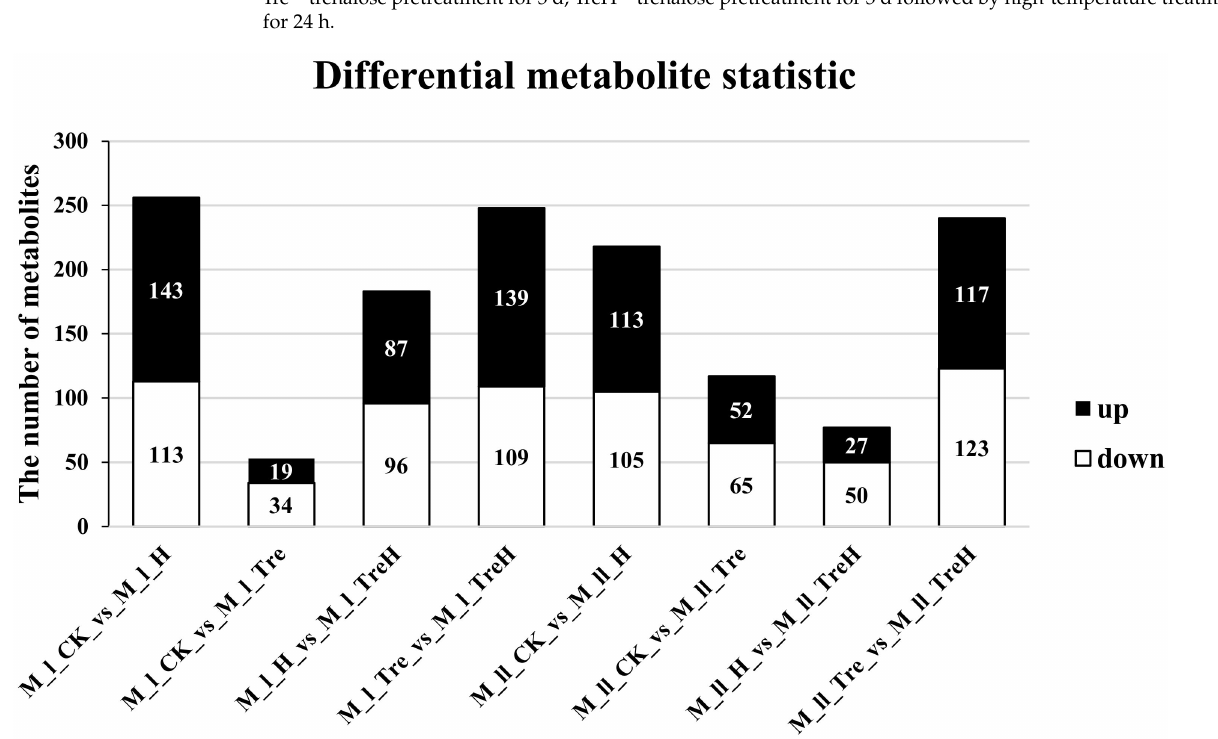
Figure 9. Differential metabolite statistics. M—the metabolomics; I—Yangmai 18; II—Yannong 19; CK—control group; H—heat stress treatment for 24 h; Tre—trehalose pretreatment for 3 d; TreH—trehalose pretreatment for 3 d followed by high-temperature treatment for 24